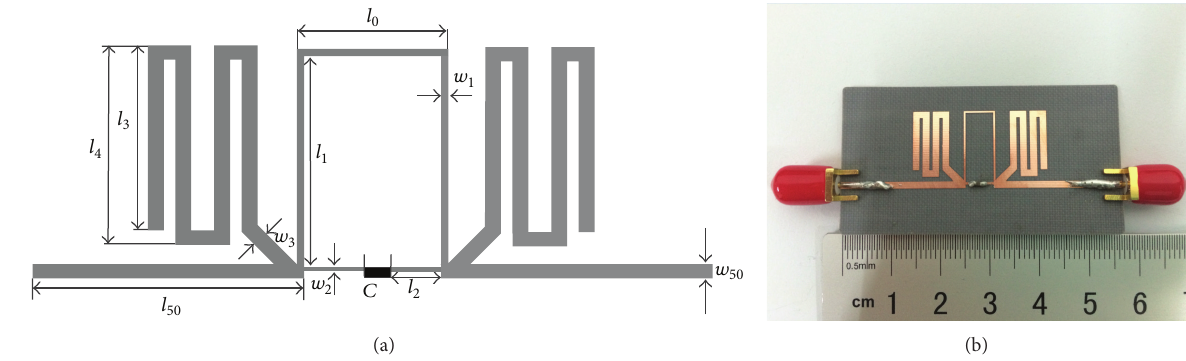
Figure 6: (a) The layout and physical dimensions of the proposed LPF. (b) The photograph of the proposed LPF.